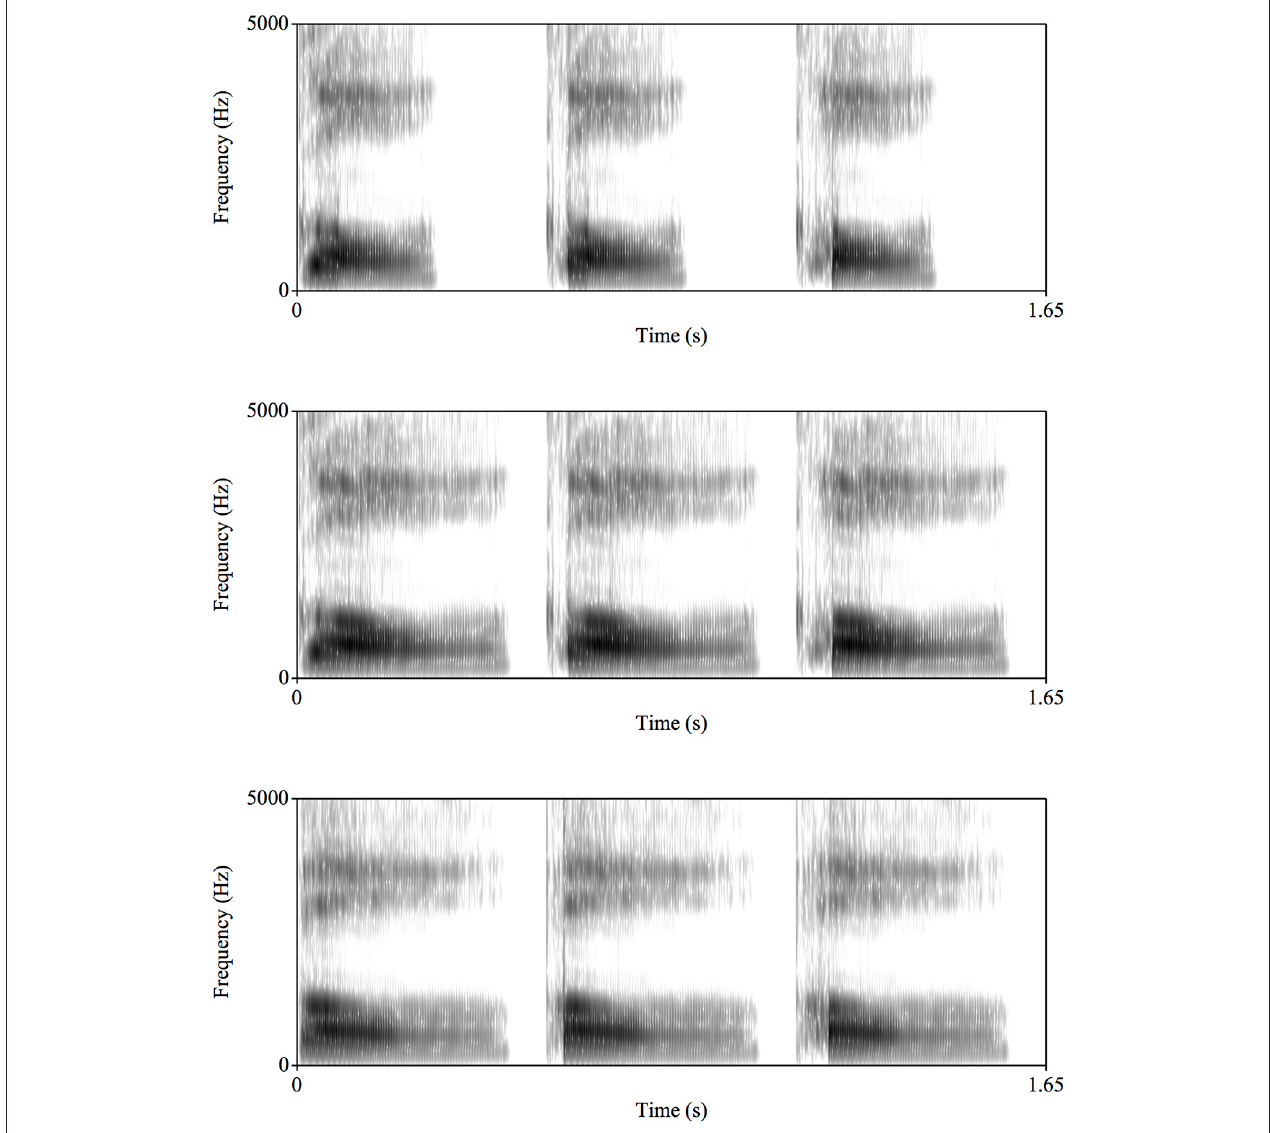
FIGURE 1 | Spectrograms for the voiced endpoint (step 1), midpoint (step 8), and voiceless endpoint (step 15) for the fast velar continuum (Top) , slow velar continuum (Middle) , and slow labial continuum (Bottom) . The stimuli can be retrieved from the link provided in the Data Availability Statement.